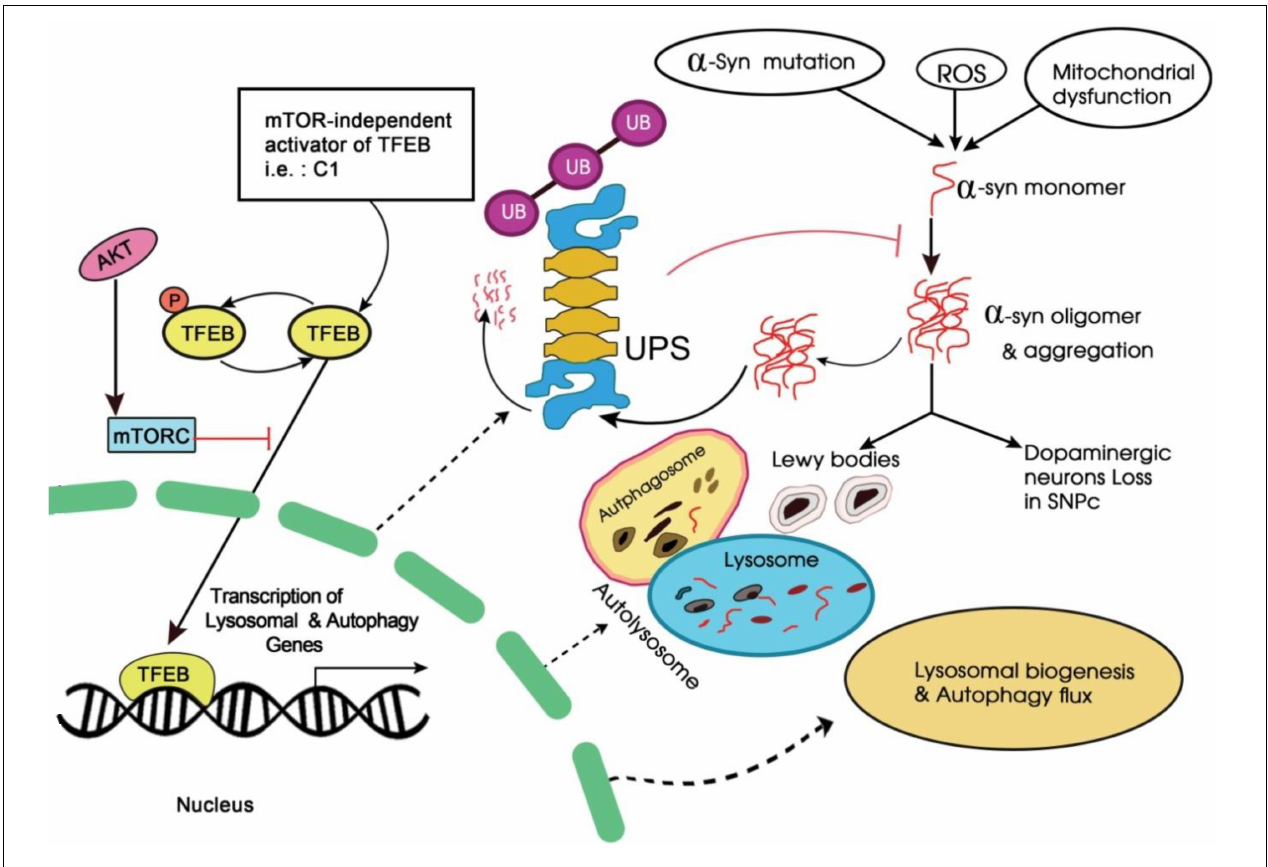
FIGURE 4 | Schematic representation of phosphoinositide 3-kinase-AKT-MTOR signaling